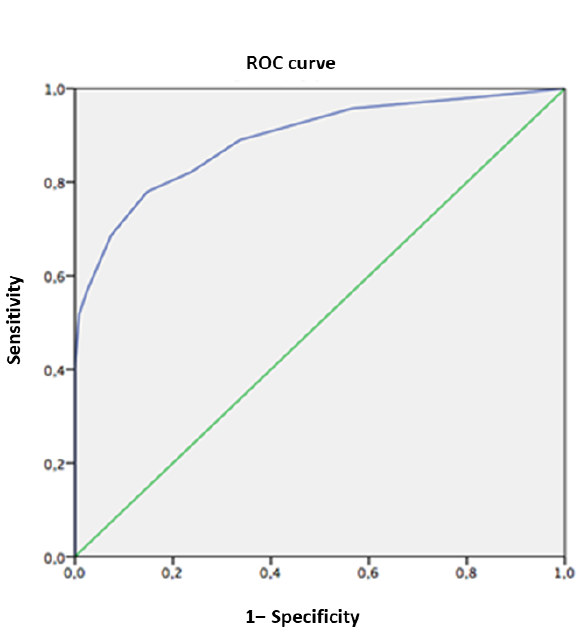
Figure 2. Receiver Operating Characteristic curve for Frontal Assessment Battery score in healthy controls and dementia patients matched by age and education